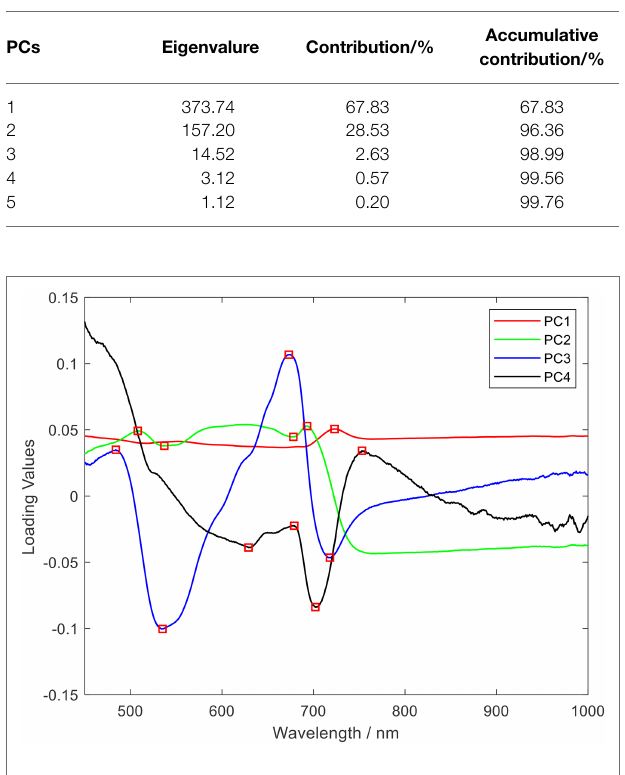
FIGURE 5 | Selected o spectral characteristics wavelength using principal component analysis (PCA) loading (The wavelength of the spectrum in red is the selected characteristic